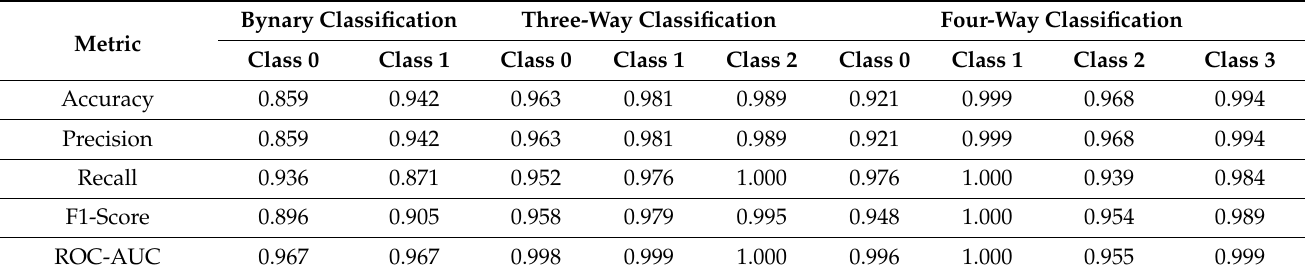
Table 5. ResNet-50 classification performance on the dataset of validated SARS-CoV-2 pneumonia frames. Three-Way Classification Four-Way Metric